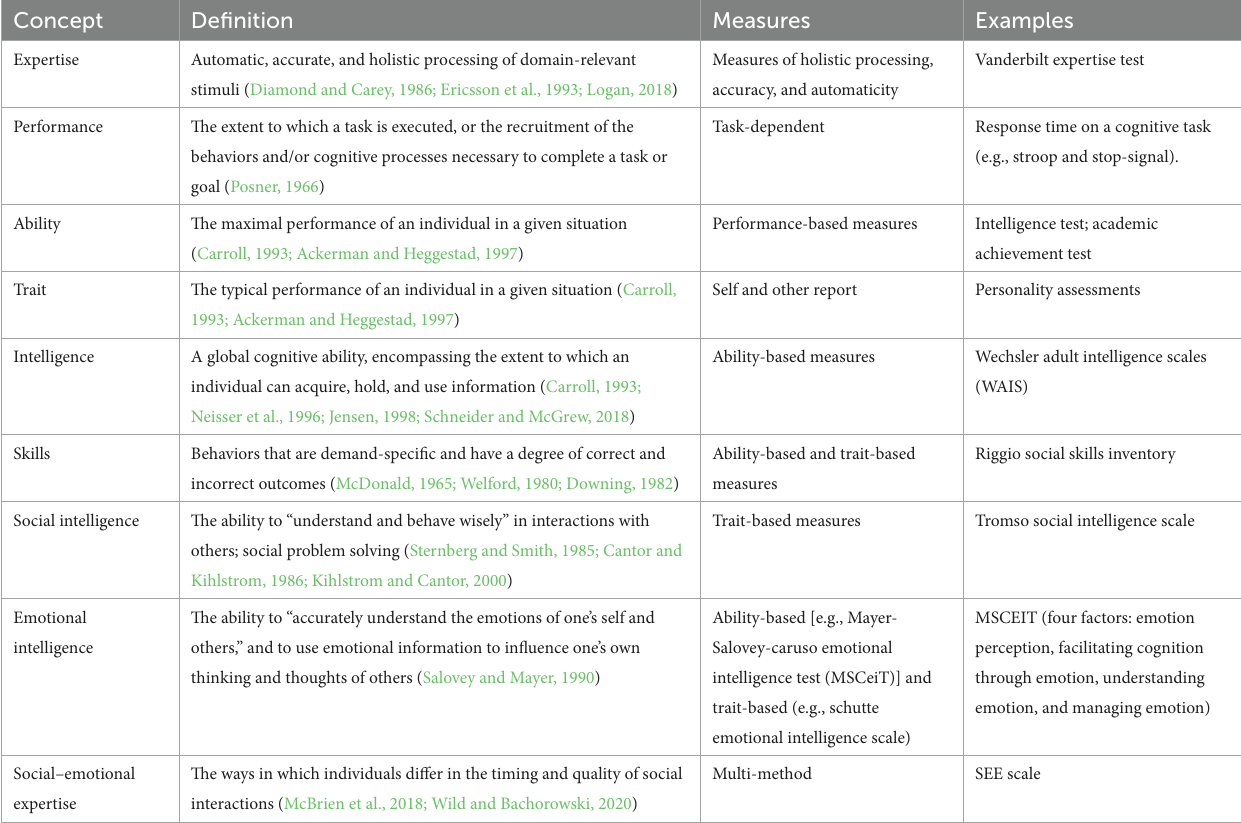
TABLE 1 Definitions and examples of concepts relevant to individual differences in social